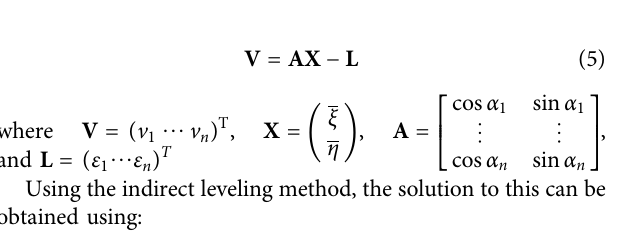
Frontiers in Earth Science |